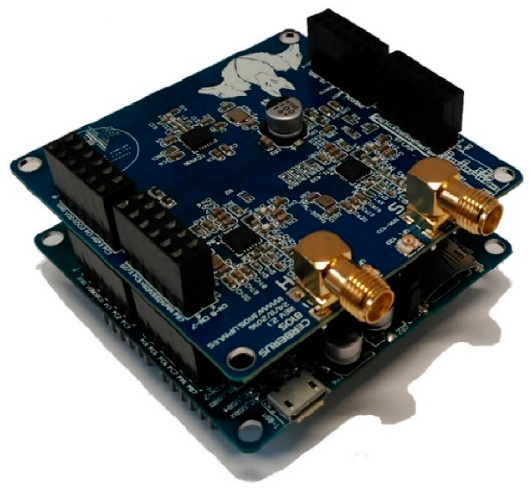
Figure 1. YetiMote Figure 1. YetiMote Node.